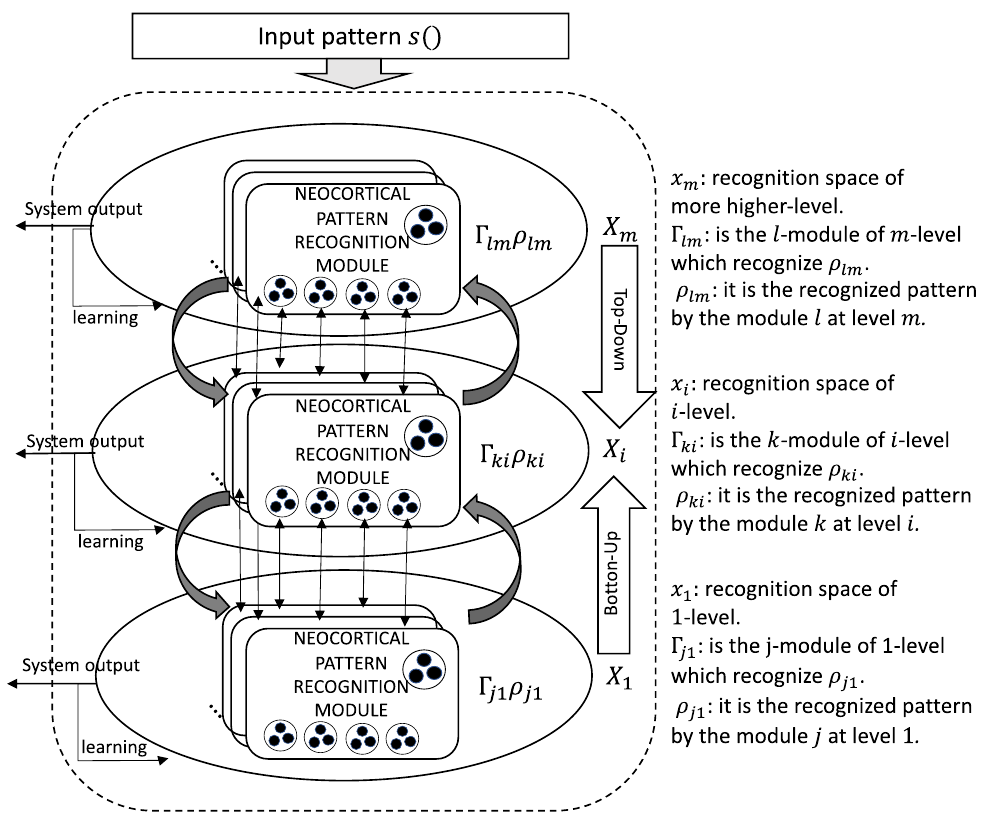
Figure 3. Recursive pattern matching model (Ar2p).